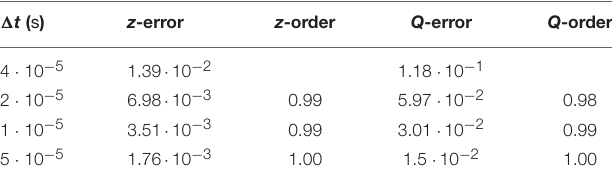
TABLE 4 | Relative errors in bubble position z and flow rate Q at t = 0 . 00144s and estimated convergence orders for the links-in-series test case computed with the semi-implicit